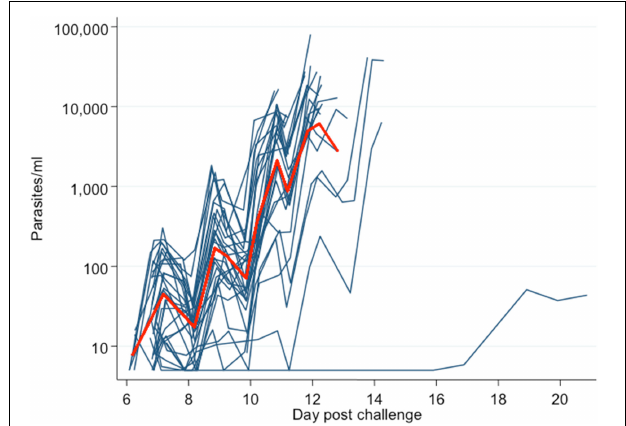
FIGURE 4 | qPCR-measured parasite density for each individual subject. Y-axis = parasites/mL. X-axis = days post challenge (calculated from hours post challenge). Red line = mean parasite density over time for all